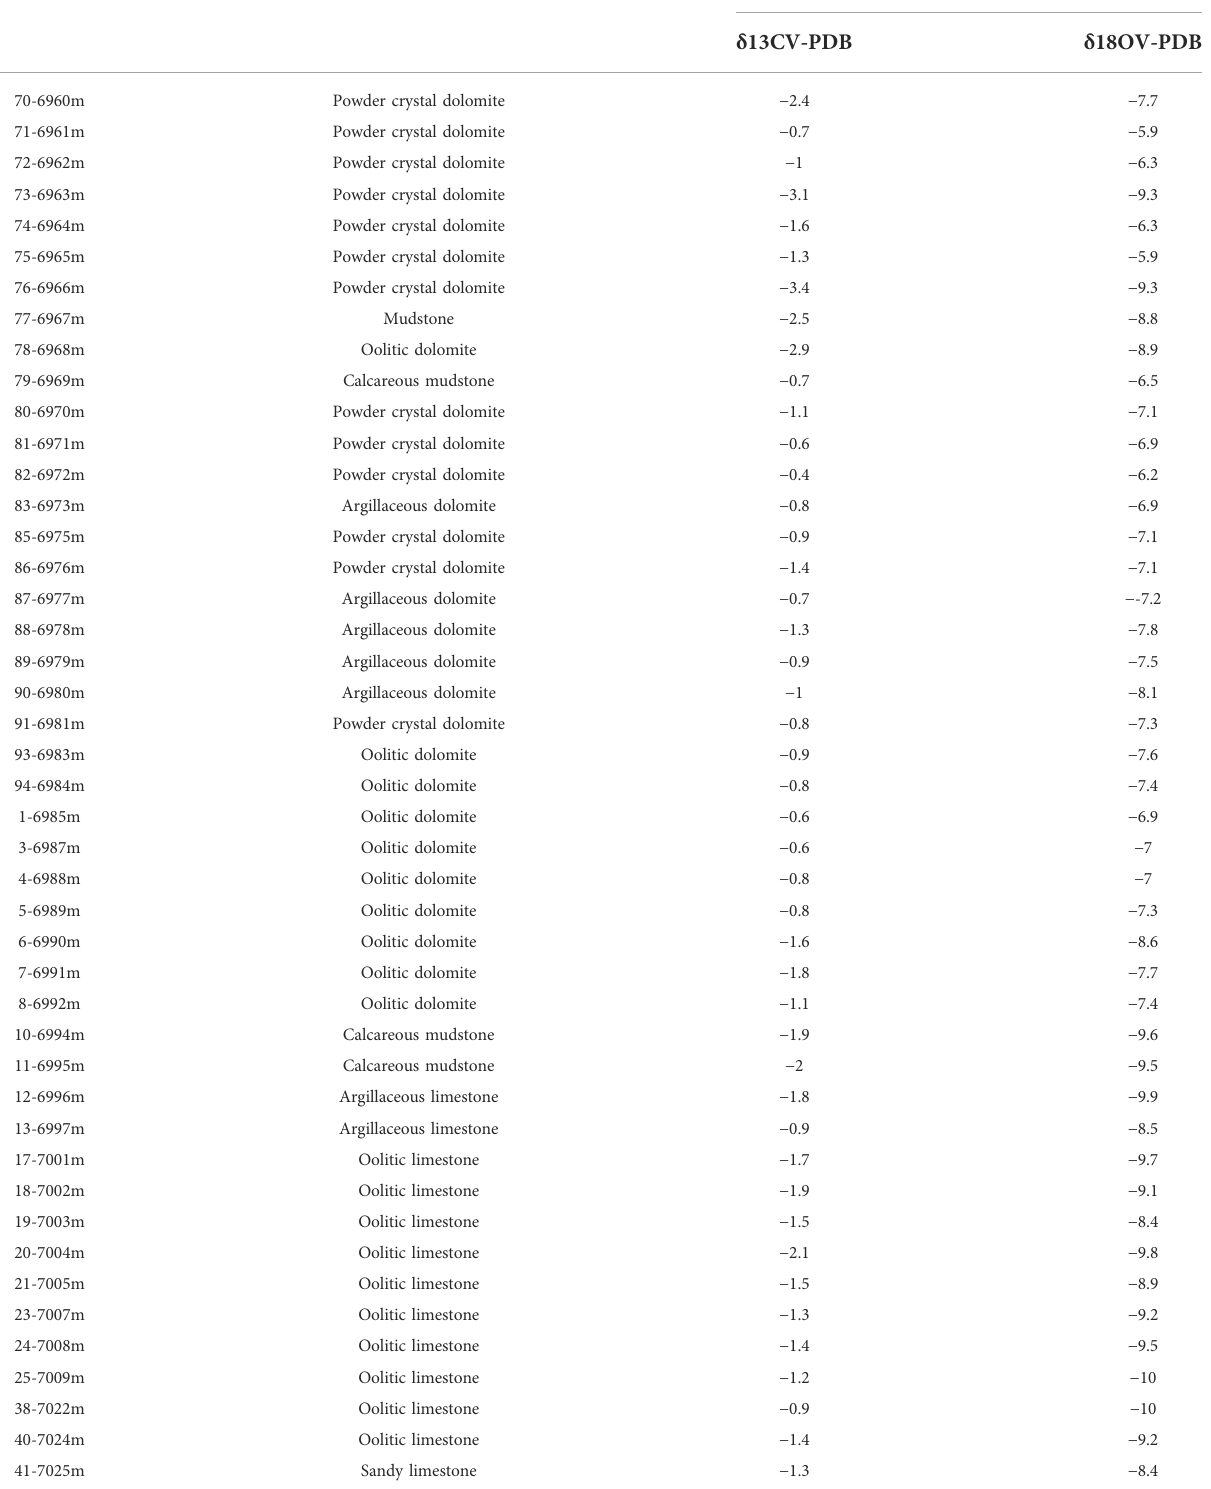
TABLE 2 Contents of carbon and oxygen isotopes in the fi rst member of Canglangpu Formation of the Cambrian Series 2 in well JT1, central Sichuan Basin (Ma at el., 2022). Sample